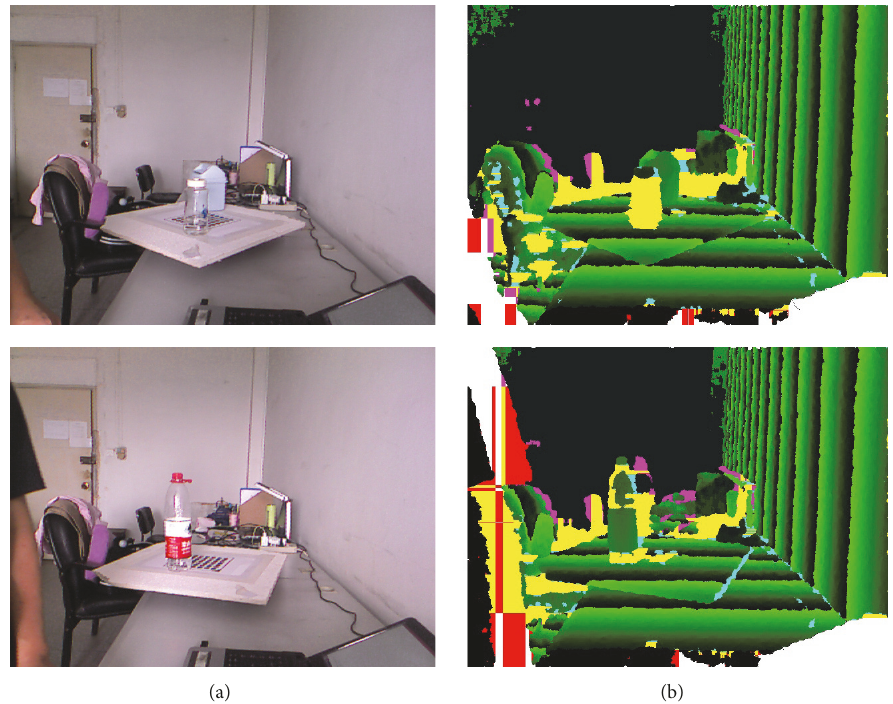
Figure 2: Depth classification result; (a) is color image and (b) is depth image after depth classification. Green: measured depth and the intensity stands for different depth values. Since the 255 intensity value is not enough for the depth value representation, the measured depth is drawn periodically to reflect the depth change. Cyan: shadow noise. white: score ∈ [−∞,−4) means out-of-range ZD. Pink and red: score ∈ [−4, 0] means out-of-range ZD, and pink labels too far ZD which should be filled by background depth. Yellow: score ∈ (0, ∞) means possible transparent noise.